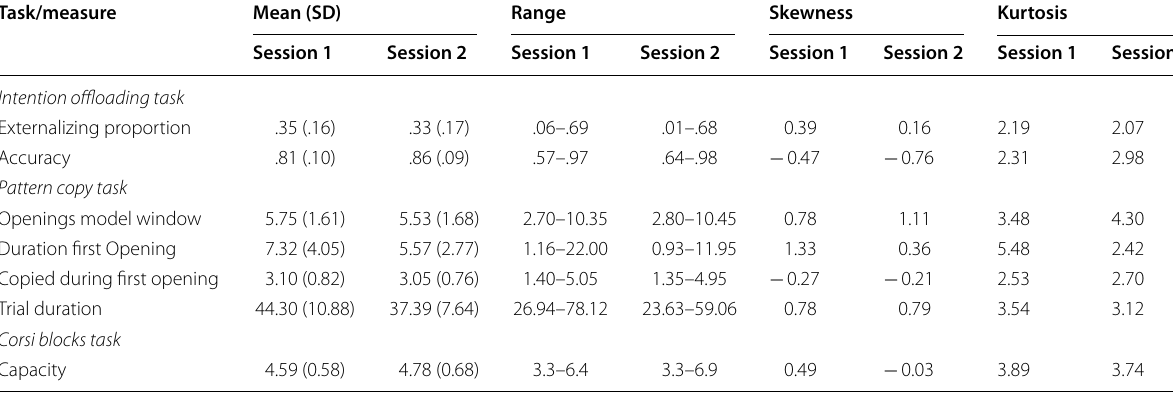
Table 2 Descriptive statistics for all investigated variables